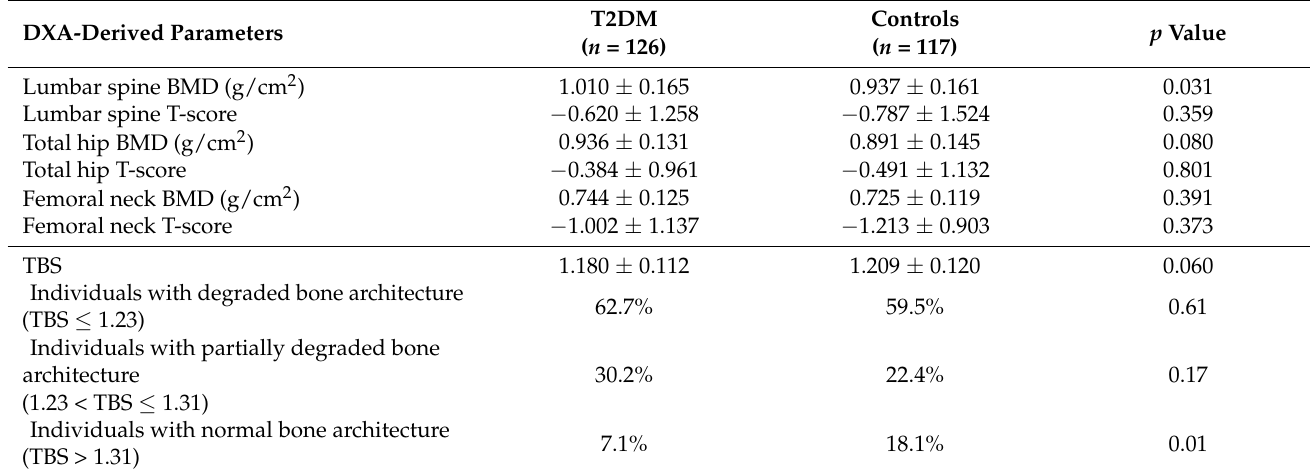
Table 2. Differences in bone parameters between patients with T2DM and